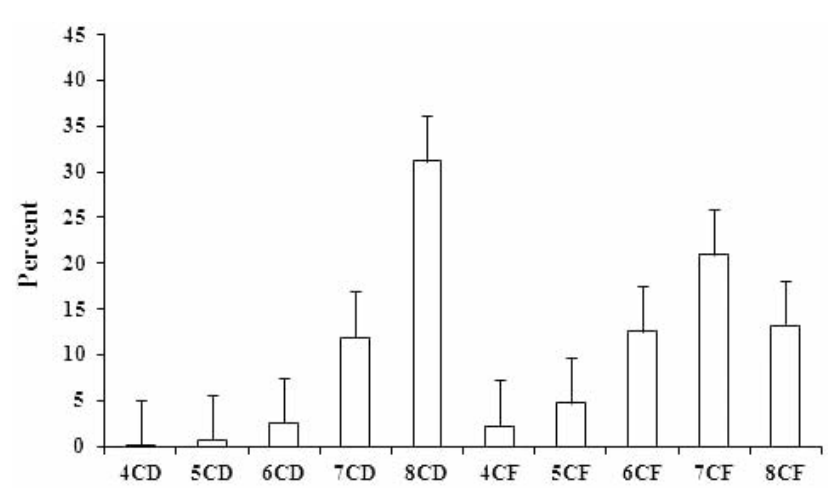
Figure 2. Percent of native polychlorinated dibenzo -p- dioxin/dibenzo -p- furans homo- logues in ambient air (PM ) in Delhi. 10